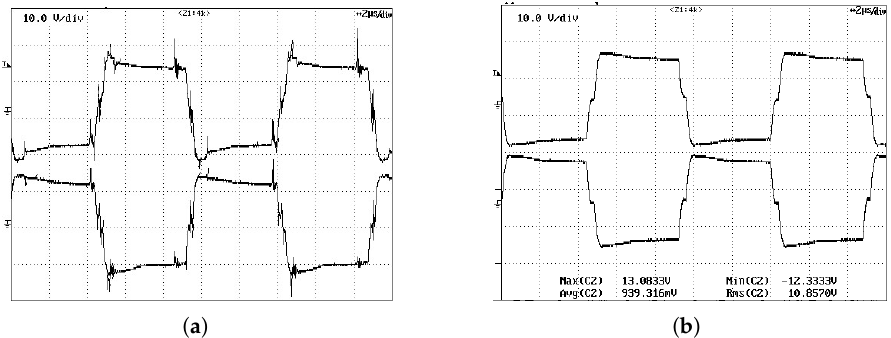
Figure 10. Voltagewaveformsofthedrivesignal. ( a )Withoutsaturableinductors; ( b )Withsaturableinductors.